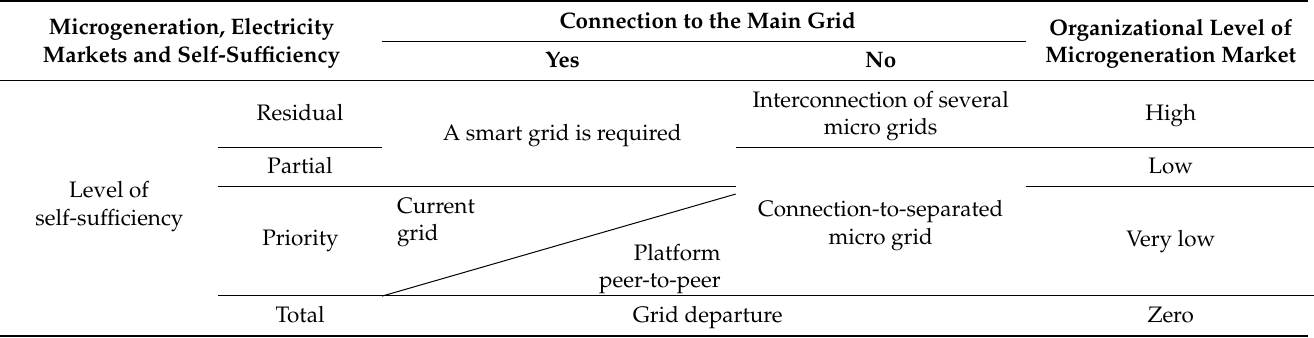
Table 1. Microgeneration, new electricity markets and self-sufficiency. Connection to the Main Grid Organizational Level Microgeneration, Electricity Markets and Self-Sufficiency